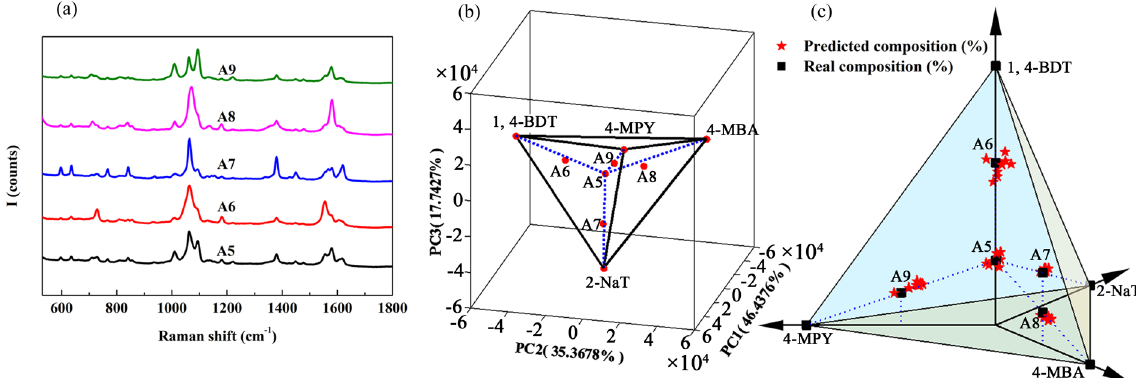
Figure 5. ( a ) SERS spectra of quaternary mixture sample A5 to A9. ( b ) Plot of PCs scores for 1, 4-BDT, 2-NaT, 4-MBA, 4-MPY, and their quaternary mixtures. ( c ) Plot of real composition in solution versus composition of corrected PCA